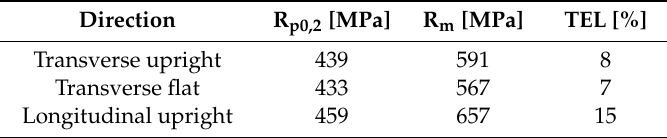
Table 3. Mechanical properties of weld specimens.